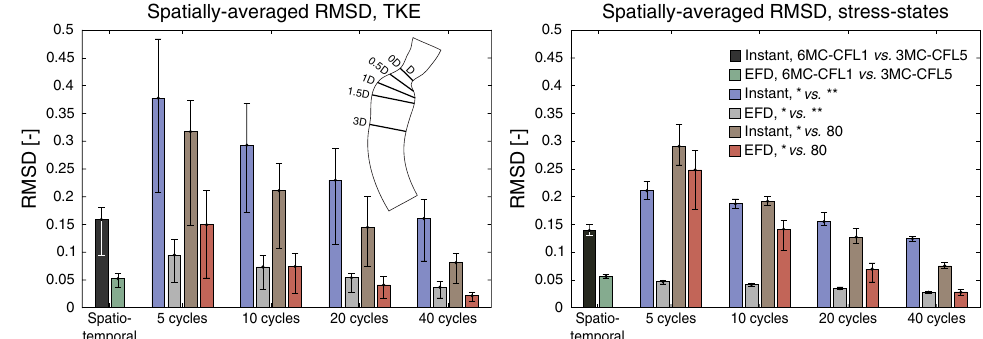
Figure 3. Spatially-averaged RMSD of the TKE and turbulence stress-states for the different sensitivity analyses, including both the time-averaged (over the EFD) and phase-instant results. The TKE was normalized by the Q 3 value of the TKE (58 Pa) in the concerned turbulent region of the most resolved case (6MC-CFL1). The errors (bars) were calculated from the cross-sectional averaged RMSD (0D to 3D, Figures 2 and 4), including the min/max variability range. The phase-averaged errors are shown for the different independent cycle ranges (* vs. **), and against the full range of cycles (* vs. 80).